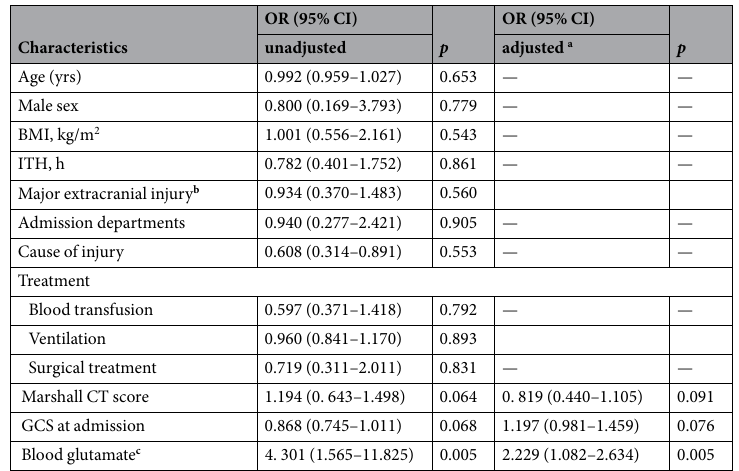
Table 3. TBI-ALI Outcome in Relation to Baseline and Treatment Characteristics of Patients with TBI. ALI, acute lung injury; BMI, body mass index; GCS, Glasgow Coma Scale; ITH, time of injury to hospital; TBI, traumatic brain injury. a Adjusted for age, sex, BMI, ITH, major extracranial injury, admission departments, cause of injury and treatment measures. b The injury score was calculated according to the number of injured regions. c Represents the glutamate level on admission.